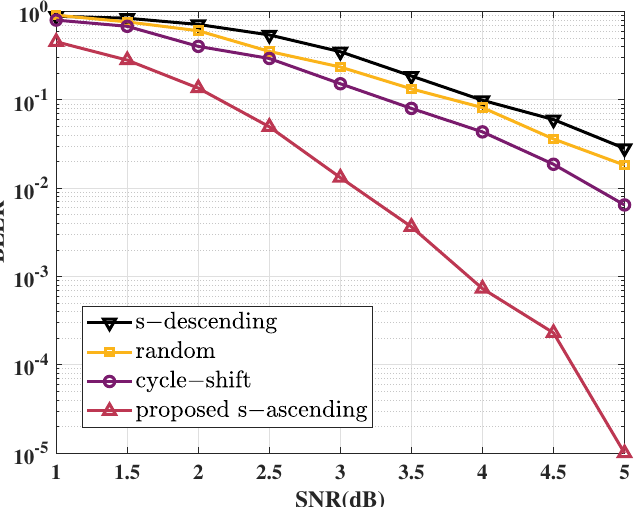
Figure 6. The comparison of BLER performance among different permutations of factor graph, where the code length is 256 bits and code rate is 1/2.